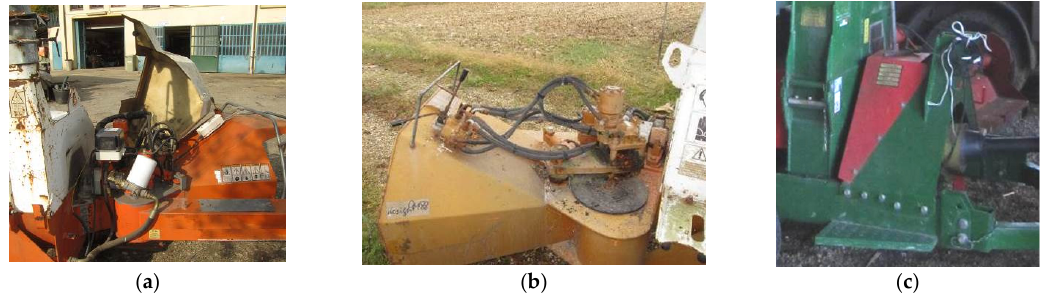
Figure 10. Observed case studies of wood chippers: pictures ( a ) and ( b ) show chippers equipped with an easily removable hood that, when open, leaves the hydraulic lines without protection, on the right ( c ) a case study with a fixed repair (bolted hood).